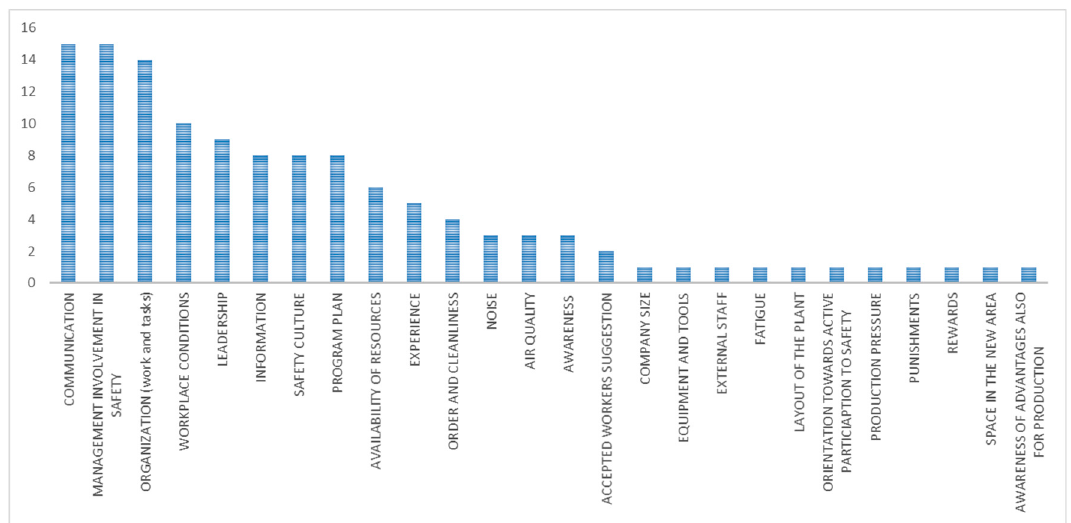
Figure 8. Main contextual factors (in terms of number of occurrences) in technical interventions with expected outcome.